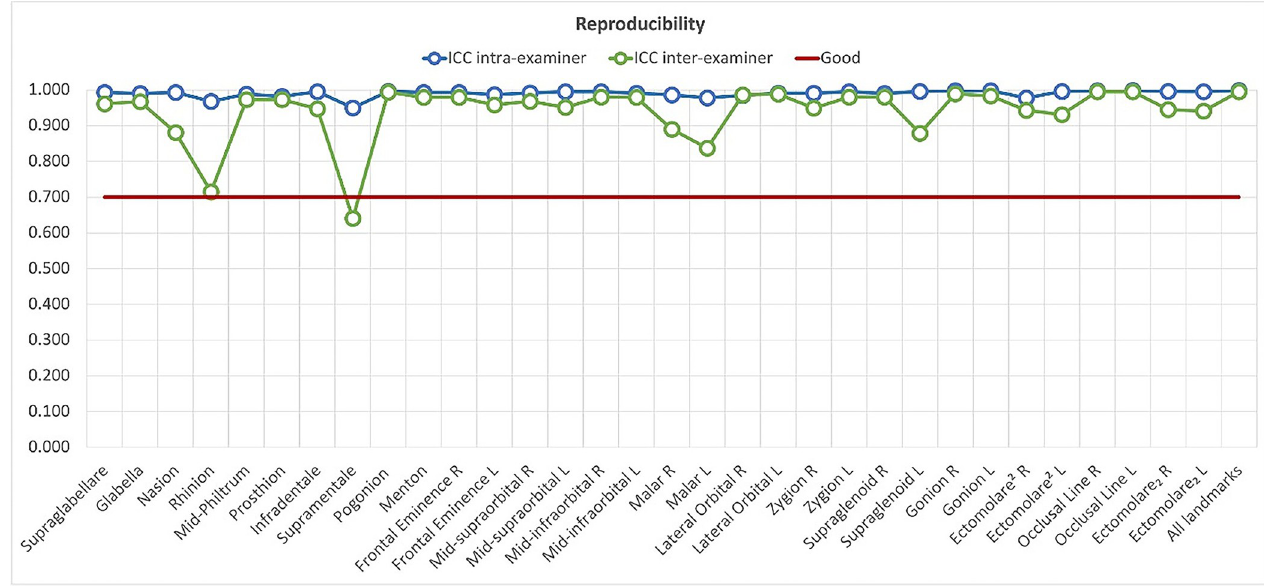
Fig 4. Concordance level for each landmark in intra- and interobserver analysis.